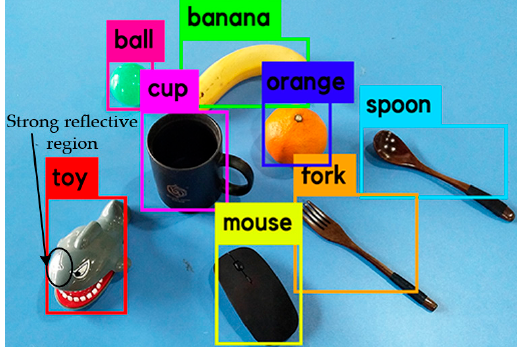
Figure 5. Diagram before object has been “locked”.